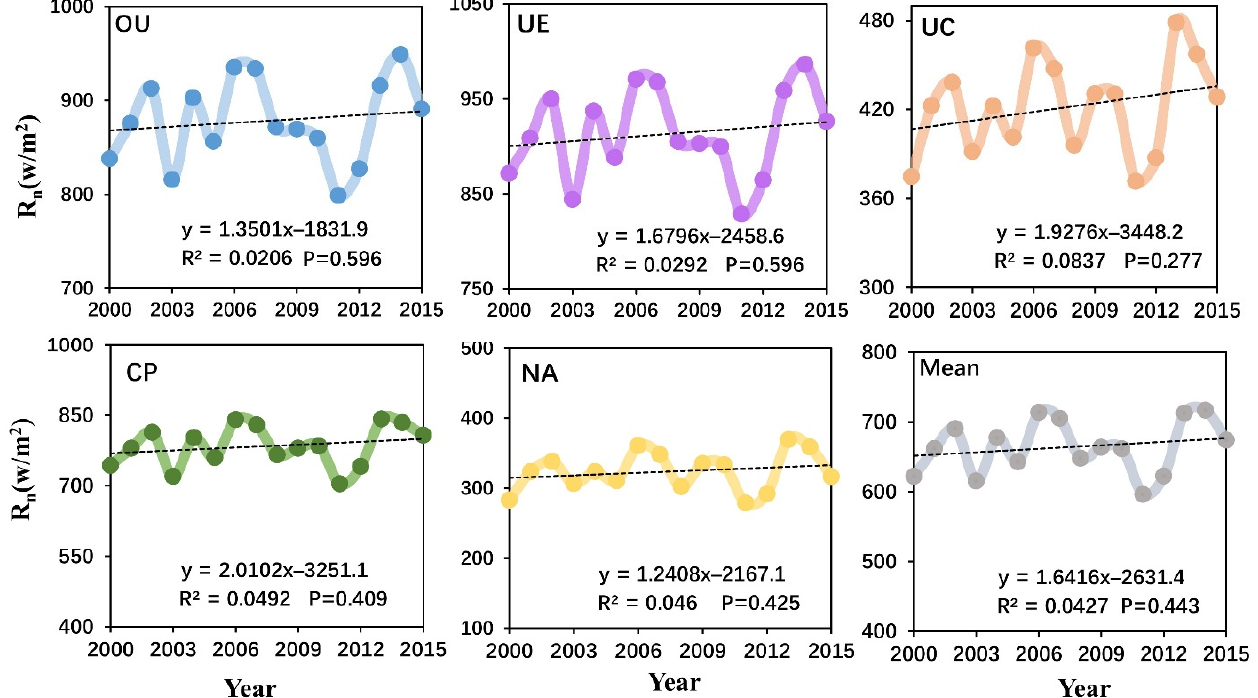
Figure 8. Net radiation ( 𝑅 (cid:3041) ) trend of different land use types in the influence area of the YRB from 2000 to 2015.